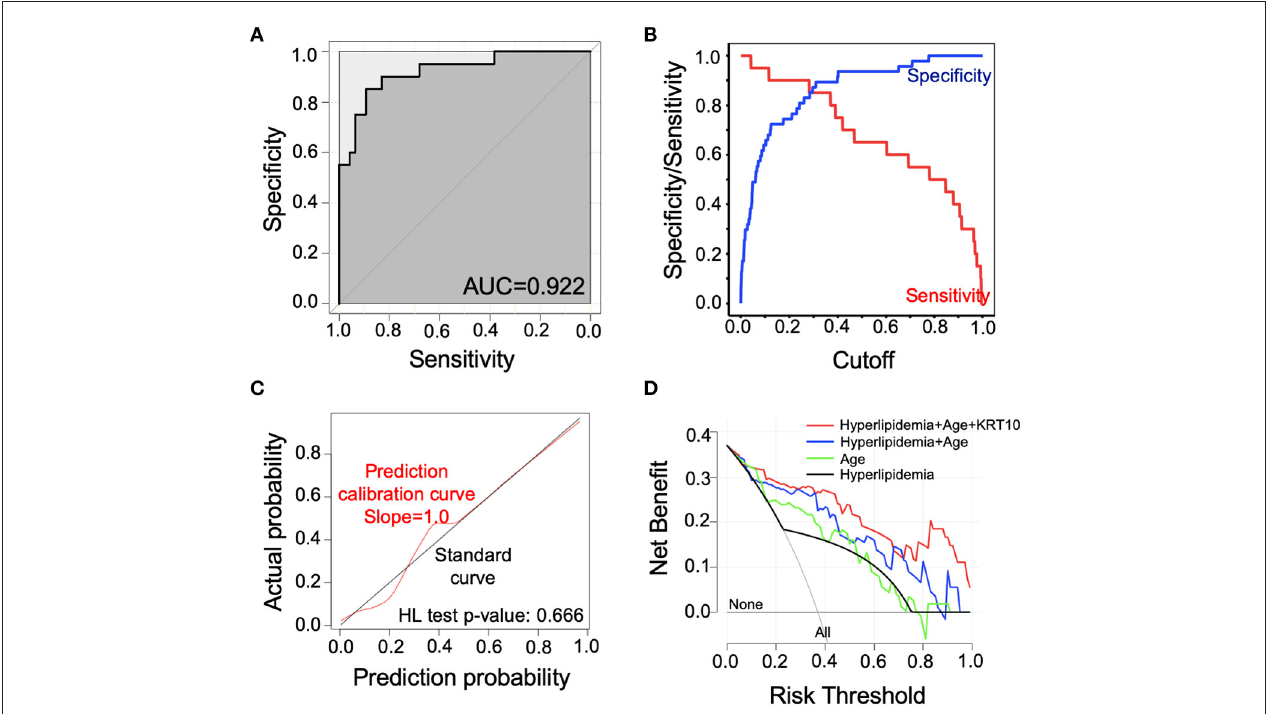
FIGURE 3 | Evaluation of the performance of the risk prediction model. (A) Receiver operating characteristic (ROC) curve of the prediction model. (B) Sensitivity and specificity of the prediction model with different cutoffs. (C) Calibration curve for the logistic regression model. The calibration curve was plotted with 1,000 times bootstrap resampling. p -value was calculated with Hosmer–Lemeshow (HL) goodness-of-fit test. (D) Decision curve analysis (DCA) comparing net benefit of different models. The net benefit of our prediction model (red line) was compared to models built by only hyperlipidemia (black line), only age (green line), and hyperlipidemia plus age (blue line). The lines labeled with “None” or “All” showed the net benefit of not treating any patients or treating all patients, respectively.